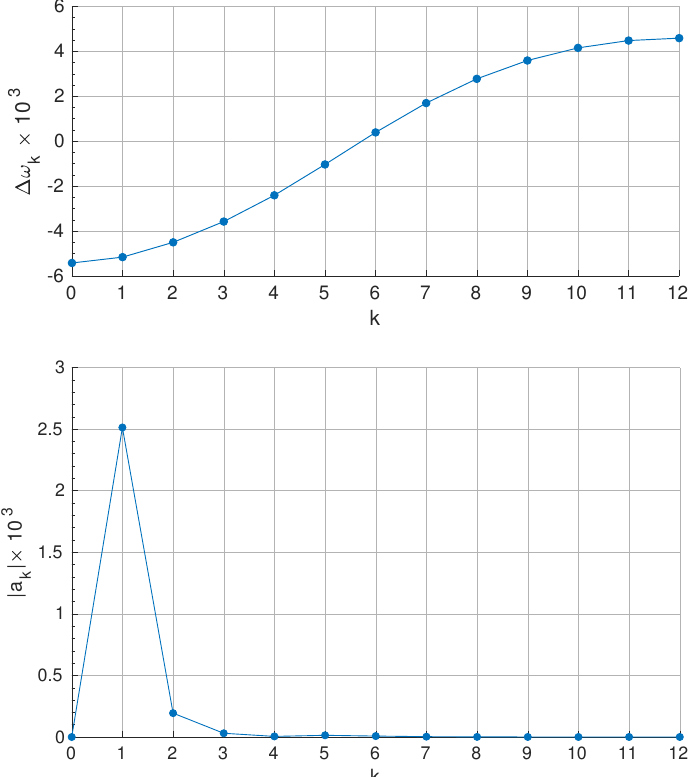
Figure 4. ( Top ): relative frequency deviations for the first modal family of Rotor A. ( Bottom ): corresponding influence